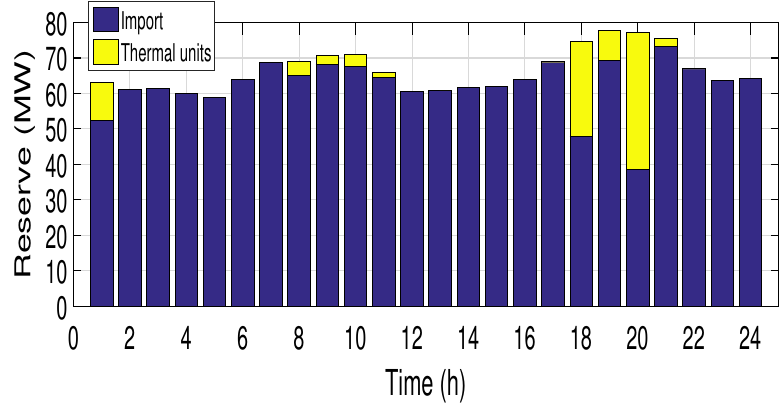
Figure 15. Scheduled power in case 2.